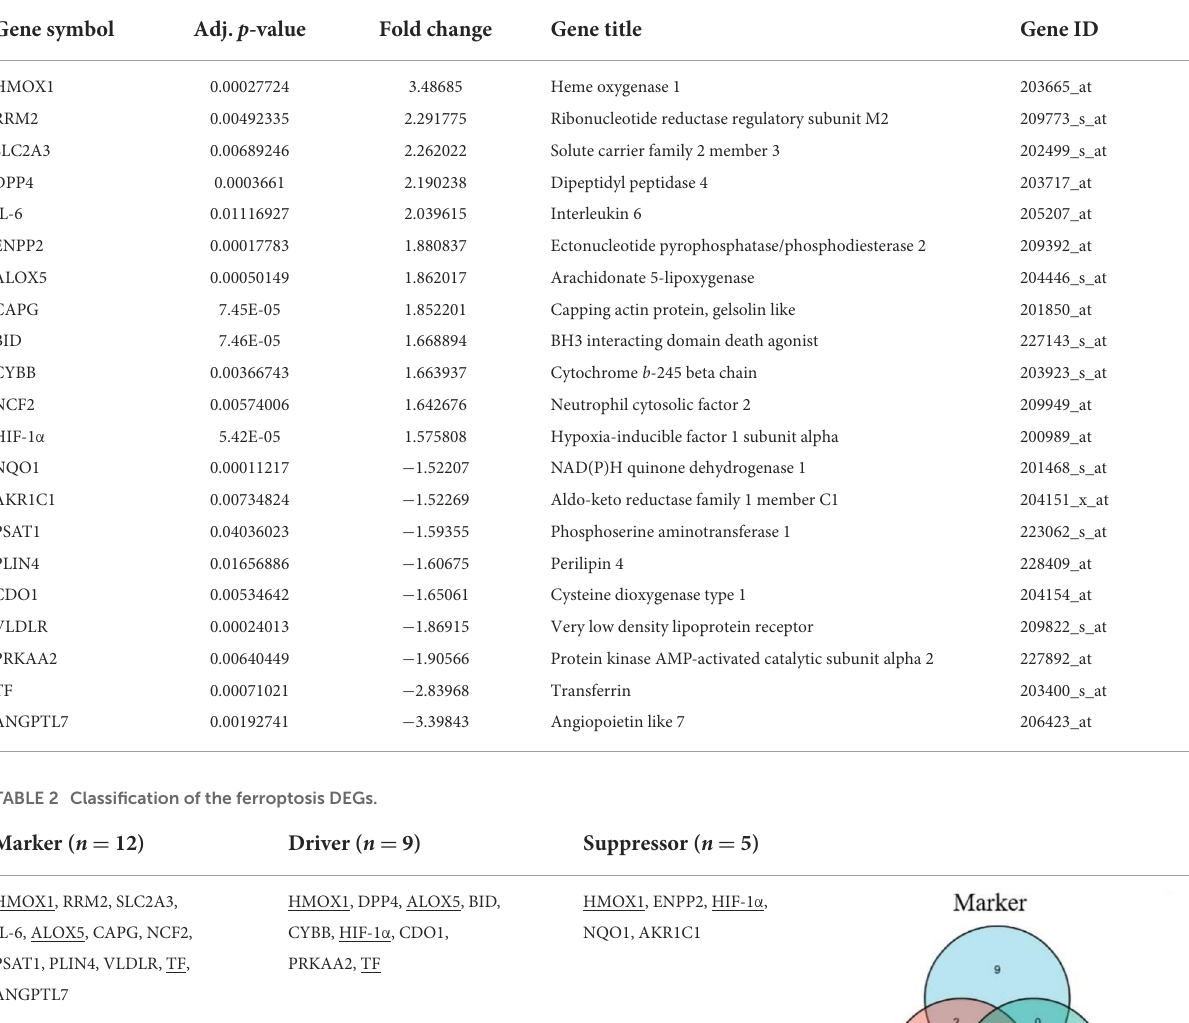
TABLE 1 Ferroptosis DEGs including 12 upregulated and 9 downregulated genes in CAVD.